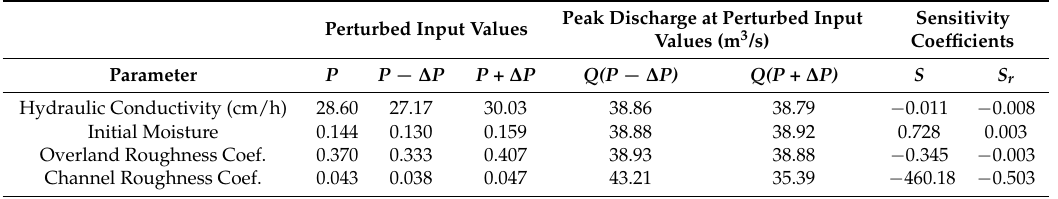
Table 7. Sensitivity analysis for peak discharge at the Demajagua River watershed.